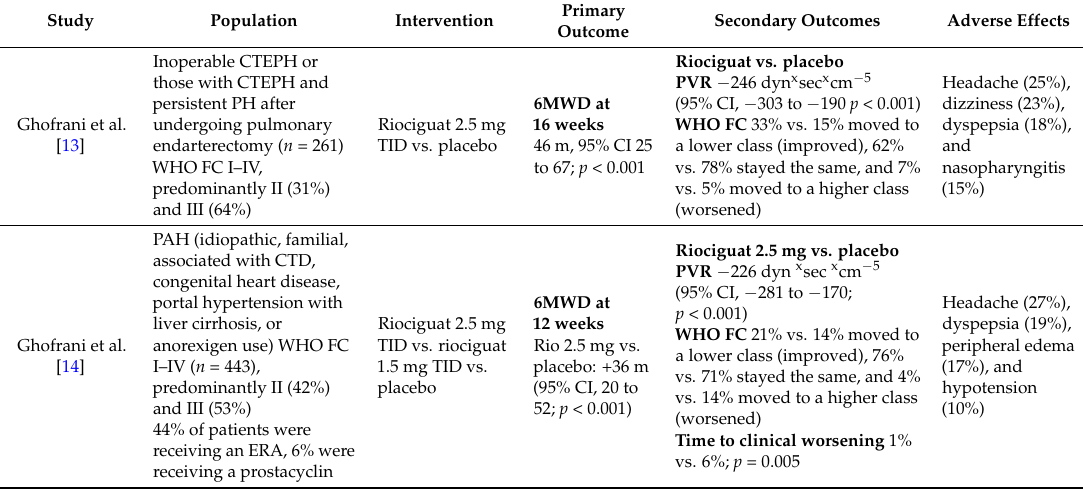
Table 2. Riociguat (Adempas ® ) Clinical